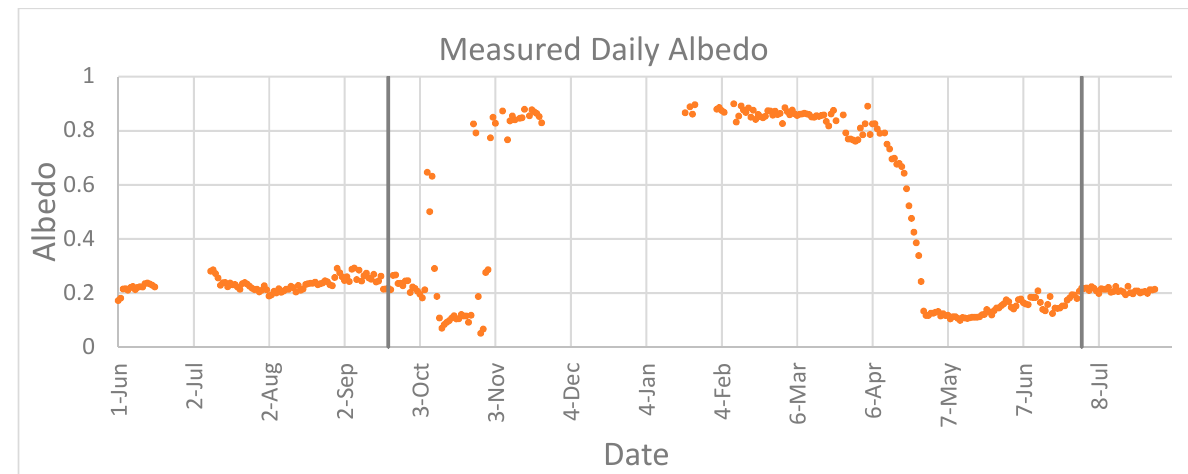
Figure 4. The daily average albedo for the study period when the solar elevation was greater than 5°. It should be noted that between 20 September 2019 and 1 July 2020 (shown with the two black vertical lines), the albedometer was located in an agricultural field adjacent to the solar test site to minimize horizon obstructions.